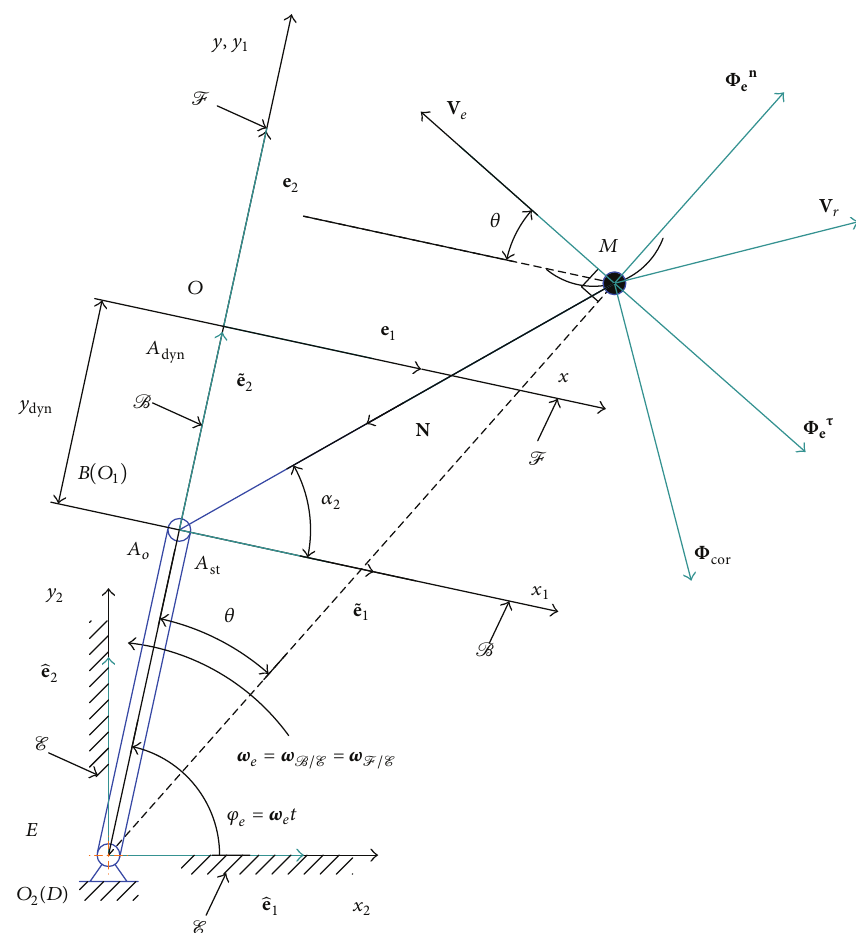
Figure 9: Swaying scheme of load 𝑀 at the cable 𝑀𝐵 , which is fixedly attached in the point 𝐵 of the crane boom 𝐵𝑂 2 , in the horizontal plane ( 𝑥 1 𝑦 1 ) for the nonlinear model derivation in Cartesian coordinates.